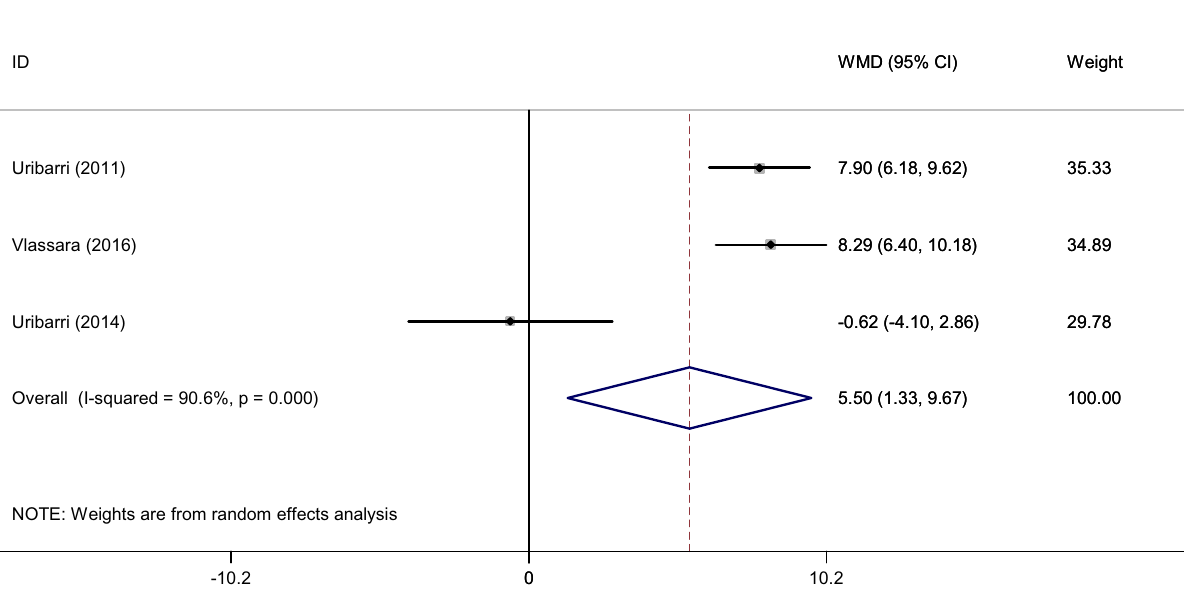
Figure 6. Forest plot of randomized controlled trials investigating the effects of low dietary AGEs on adiponectin